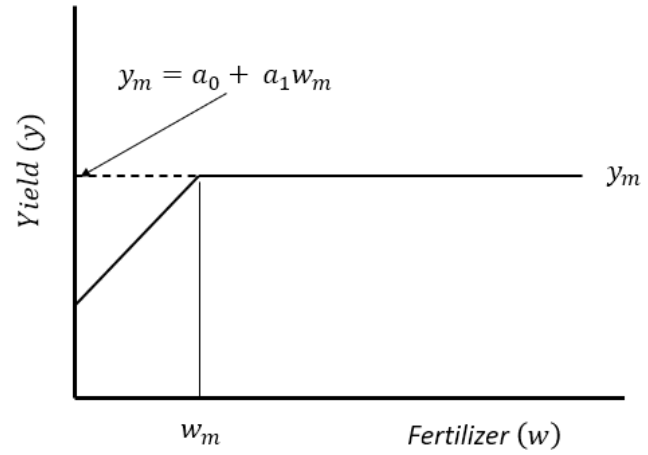
Figure 1. Deterministic response function.